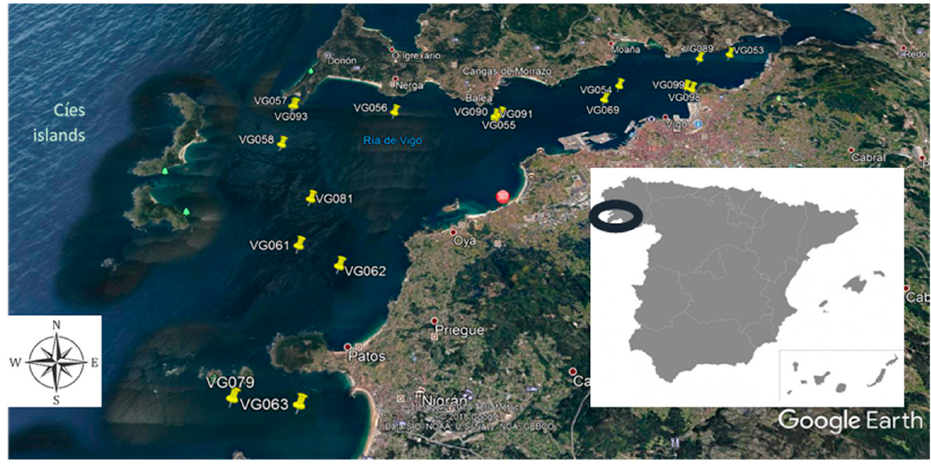
Figure 1. Sampling points along the Vigo Ría in summer 2018.